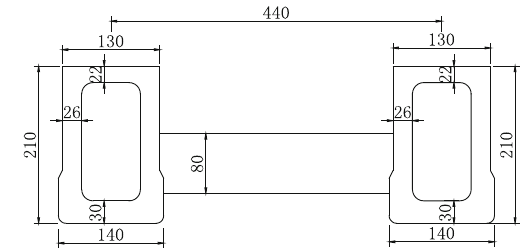
Fig. 5 Mid-span section of the track beam (unit: cm)